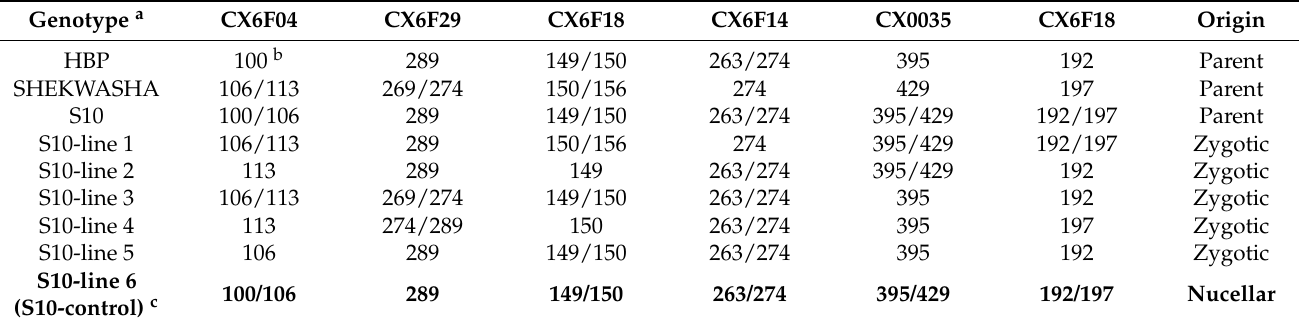
Table 1. EST-SSR marker alleles [base pairs (bp)] detected in the DNA samples from open pollinated S10 lines, the S10 seed parent, and S10 hybrid’s